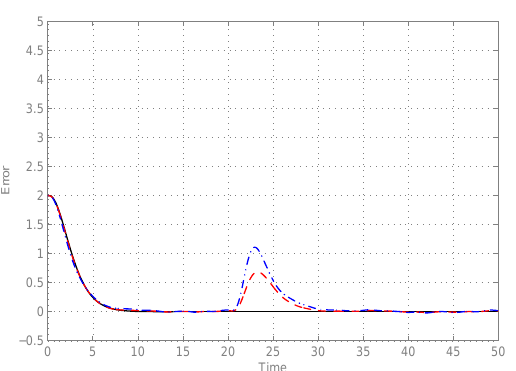
Figure 13: Position error using WKC with different conditions of wind orientation: ψ ω = 0 ◦ , ψ ω = 30 ◦ , ψ ω = 90 ◦